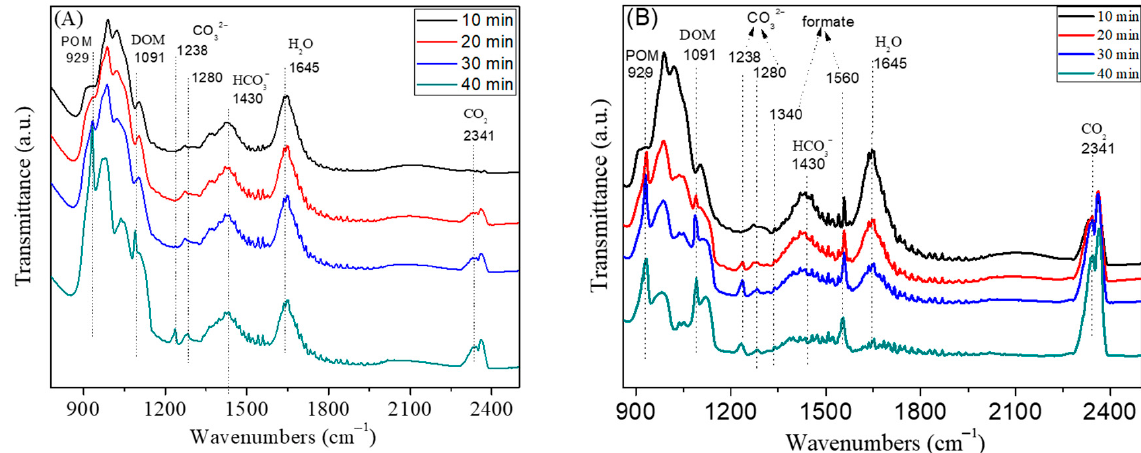
Figure 11. FTIR spectra of ( A ) 0.01BiOCl/MnMgAl − HT and ( B ) 0.01BiOCl/MnMgAlO .